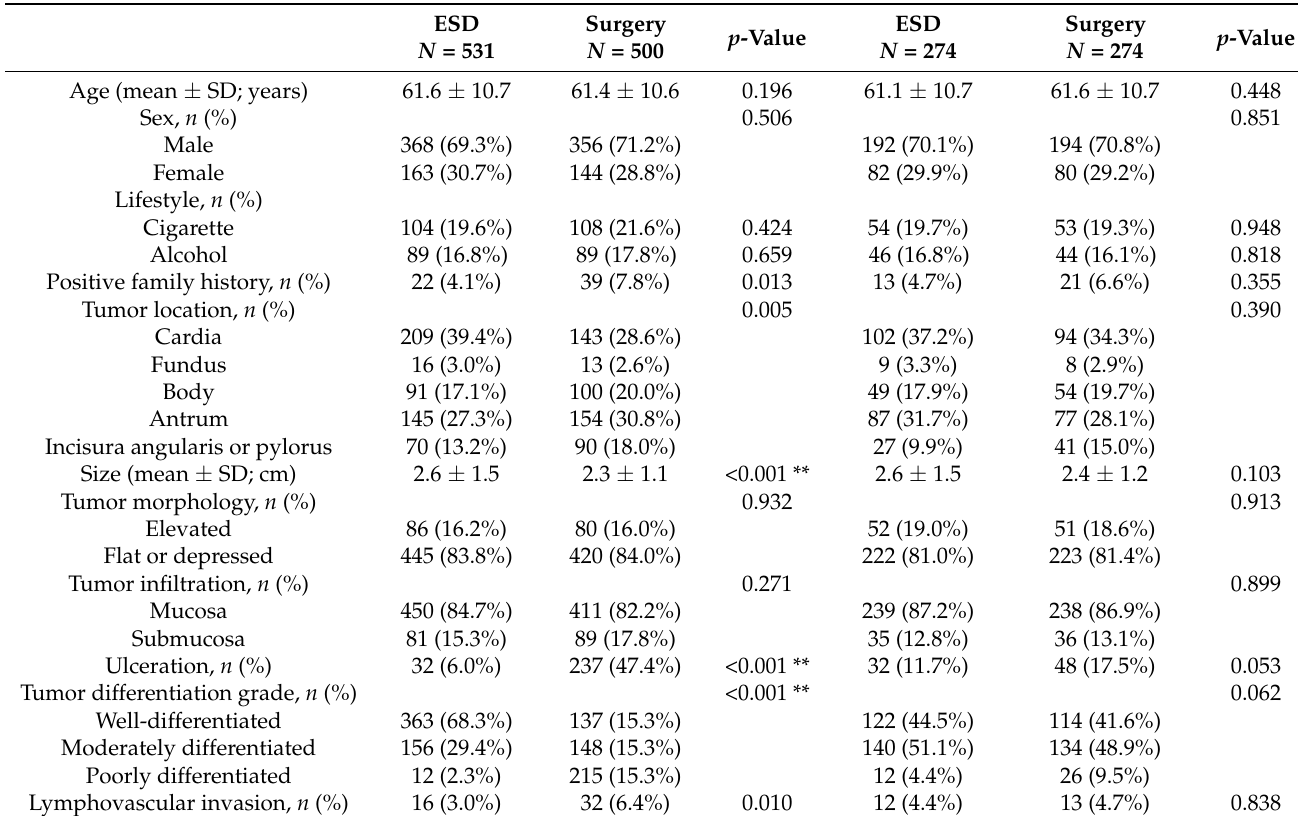
Table 1. Baseline and clinicopathologic characteristics of the study population before matching after